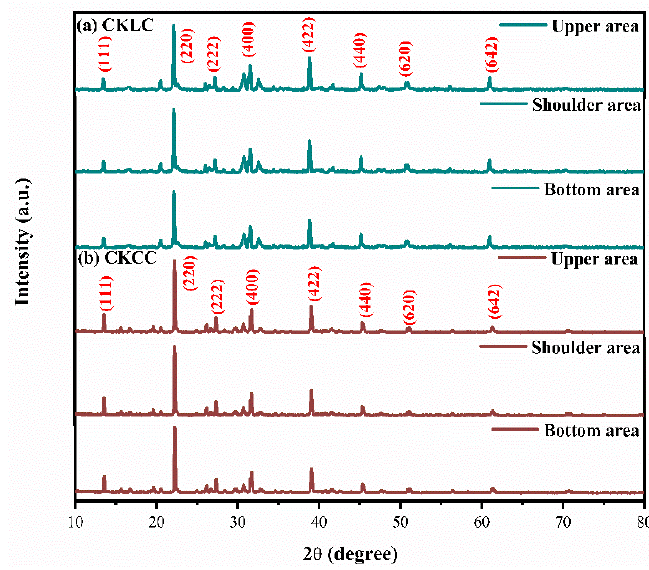
Figure 2. PXRD patterns of ( a ) CKLC and ( b ) CKCC crystals.